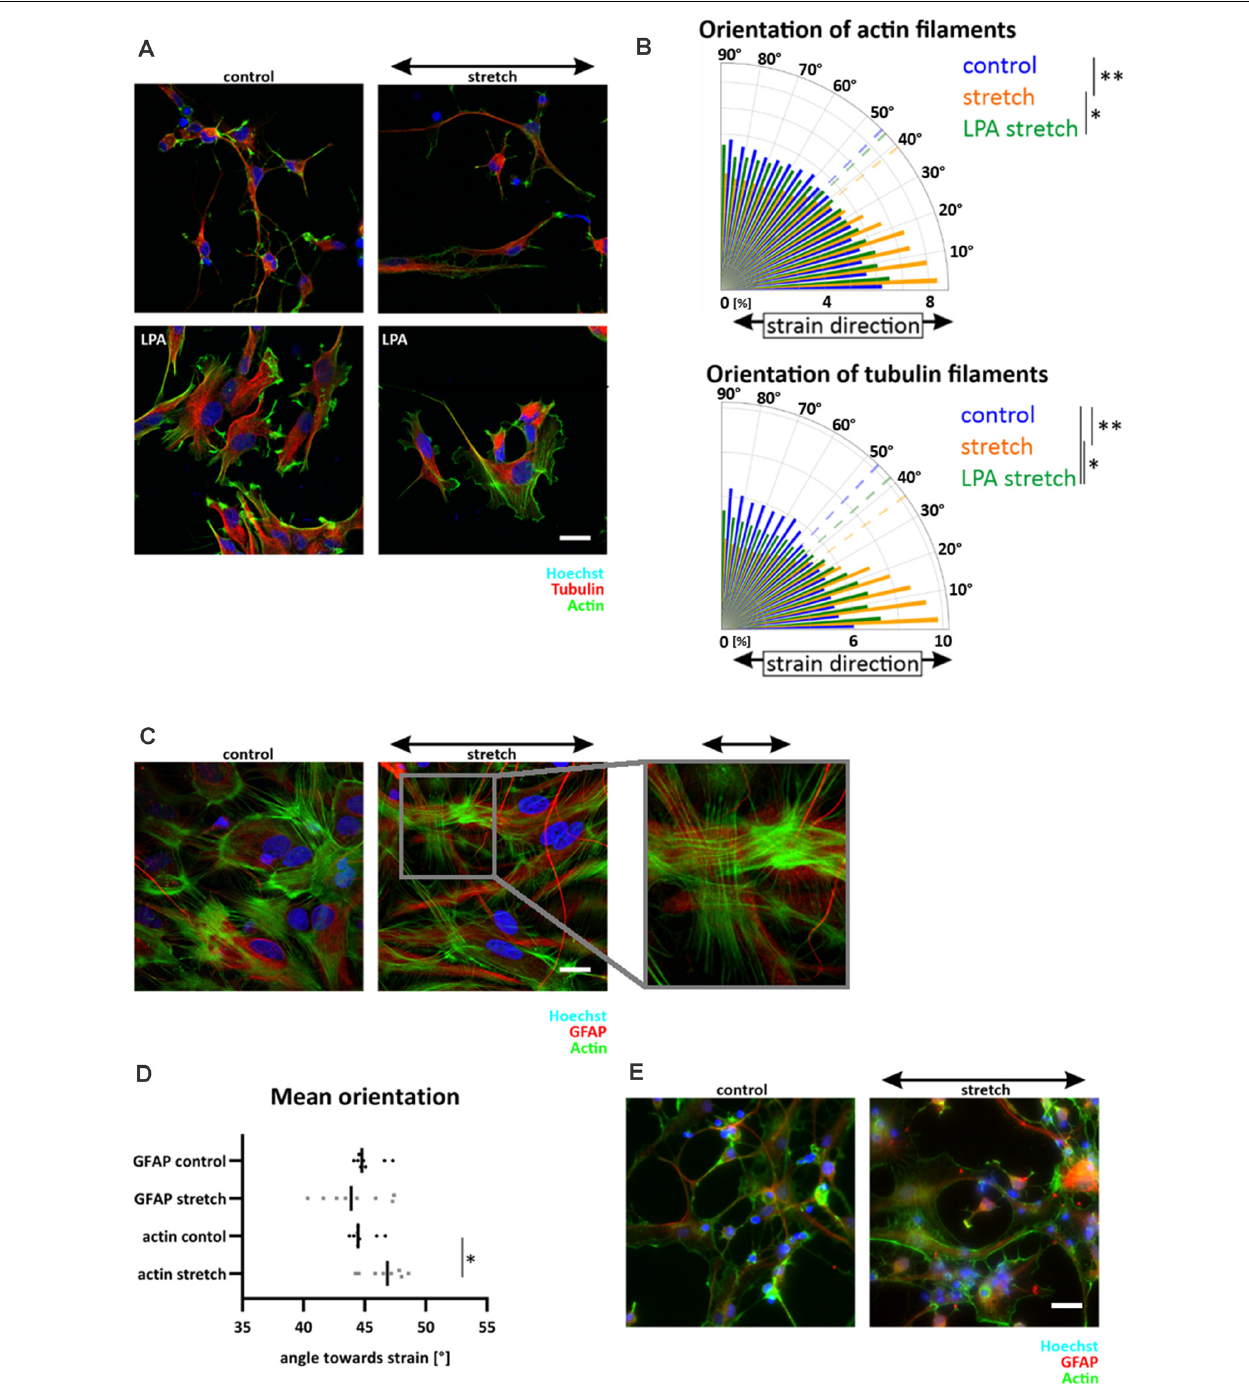
FIGURE 5 | RhoA activation in NSC reduced parallel orientation towards strain. NSCs were stretched for 24 h with an amplitude of 15% and 300 mHz, 40 min before fixation cells were incubated with 30 µ M LPA (A) . The orientation plot shows the fiber distribution of control cells, stretched cells and stretched with activated RhoA (B) , actin filament distribution: p -value LPA stretch vs. stretch = 0.0173; p -value stretch vs. control = 0.0022; tubulin filament distribution: p -value stretch vs. control = 0.00173; p -value LPA stretch vs. control = 0.0173; p -value stretch vs. control = 0.0022, n ≥ 5 independent experiments from three different passages. Postnatal astrocytes on elastomer chambers showed stress fibers in control cells or when stretched for 24 h with the same stretch parameter (C) . GFAP cytoskeleton showed a random distribution (D) while actin staining revealed significant stress fiber formation perpendicular to strain ( p -value = 0.0379, n = 8 independent experiments from three different passages). Stress fibers were not present in differentiating astrocytes (E) . Here NSCs were stretched during their mitogen withdrawal and fixed after 5 days of differentiation. Scale bars = 20 µ m. ∗ define significant differences (see “Material and Methods” section).